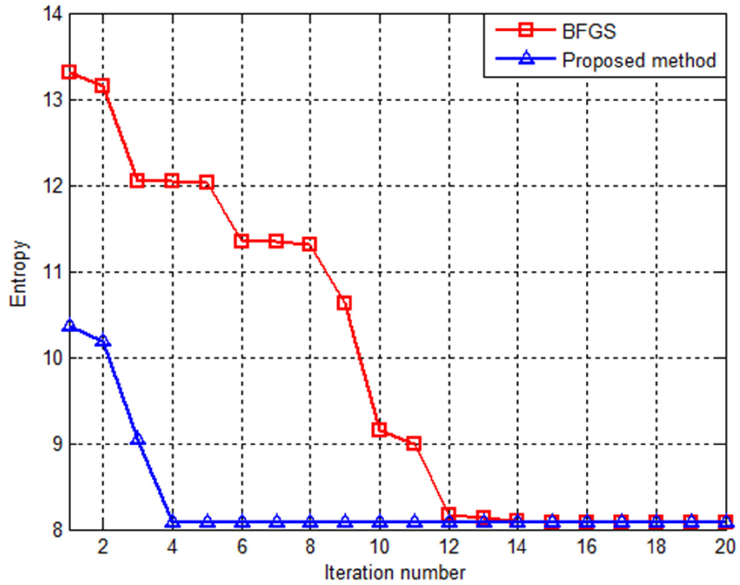
Figure 9. Comparison of image Entropy versus iteration number using different methods.